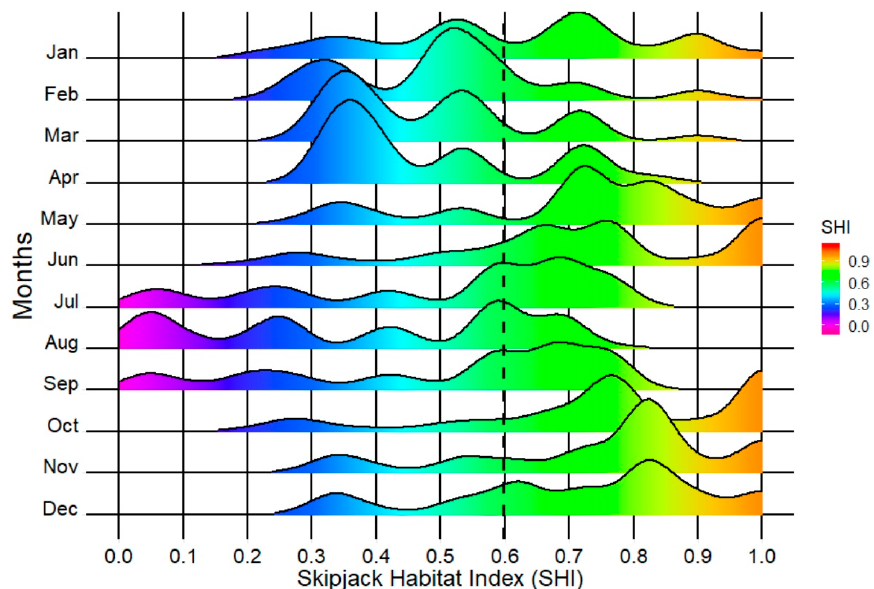
Figure 6. Temporal variability of mean skipjack CPUE ( A ) and skipjack habitat index/SHI ( B ) from January to December 2007–2016.